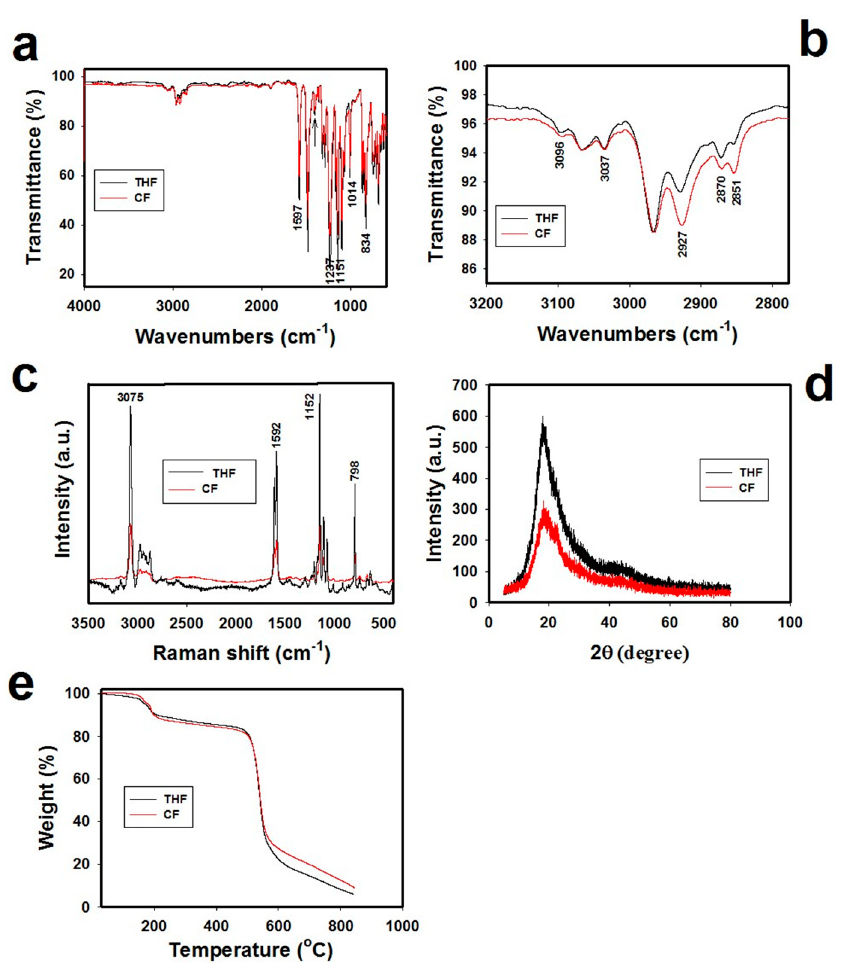
Figure 2. ( a ) Full scale of FT-IR spectra from 4000 to 500 cm − 1 , ( b ) zoomed-in scale from 3200 to 2800 cm − 1 , ( c ) Raman spectra, ( d ) X-ray diffraction patterns, and ( e ) TGA (on the left side of y- axis) & D T G (on the right side of y-axis) curve s of the PSF membranes prepared using THF and